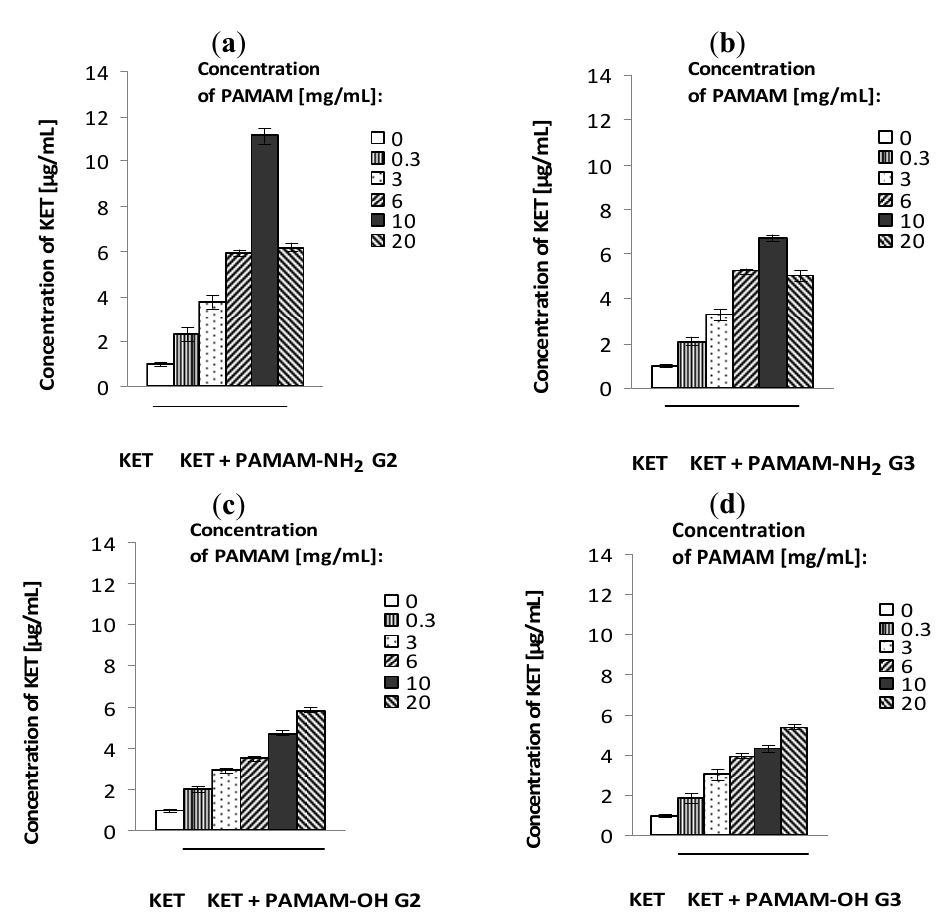
Figure 3. Solubility of ketoconazole in the presence of various concentrations of PAMAM-NH generation 2 ( a ), PAMAM-NH generation 3 ( b ), PAMAM-OH generation 2 2 2 ( c ), and PAMAM-OH generation 3 ( d ). Mean values from three independent experiments done in duplicate are